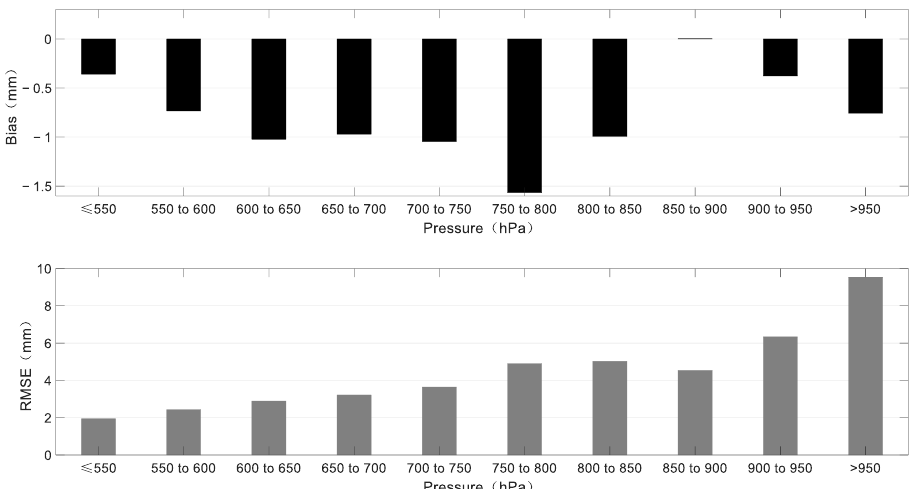
Figure 12. Annual average bias and RMSE of ASV-PWV for different atmospheric pressures for ten grid points (with No. of 911, 1774, 798, 500, 441, 403, 409, 731, 279 and 1135 respectively).